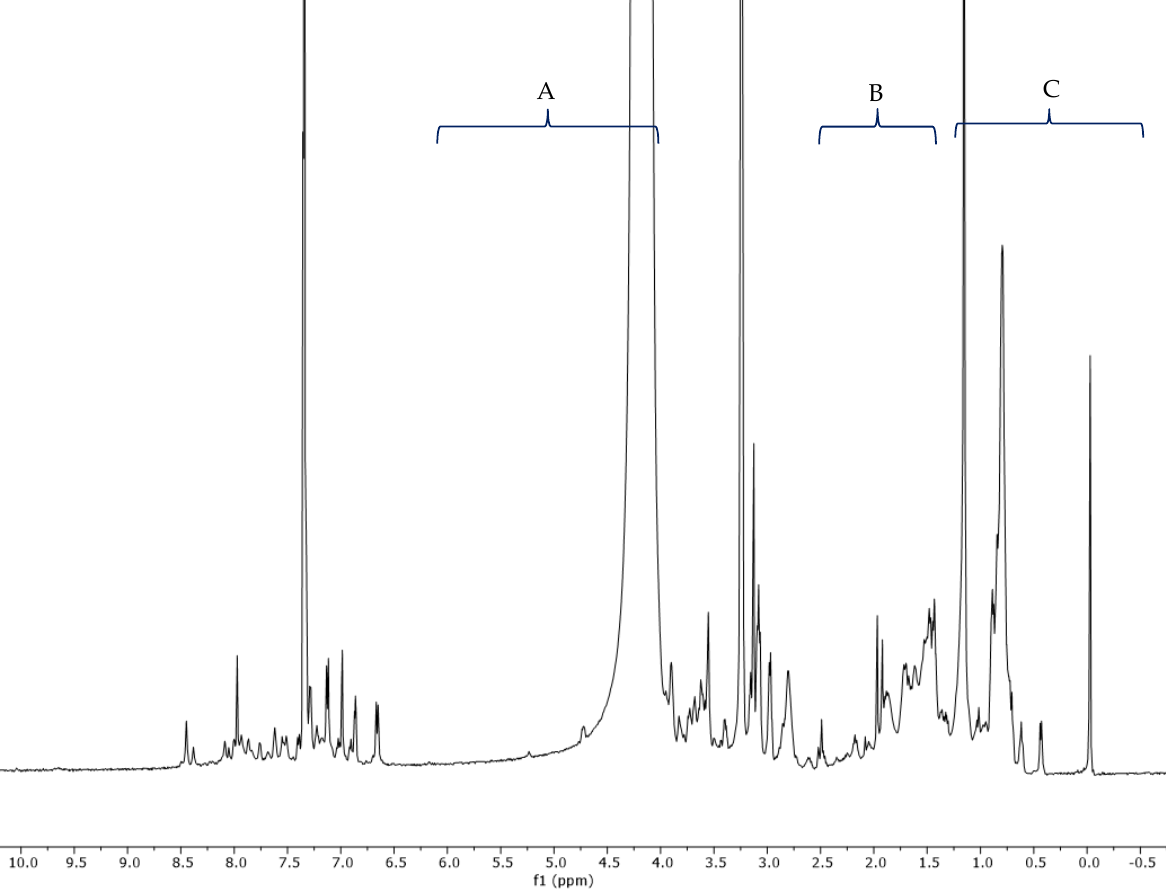
Figure 6. 1 H-NMR spectra (500 MHz, CD 3 OD) of Vespa velutina venom obtained by electrical stimu- lation.